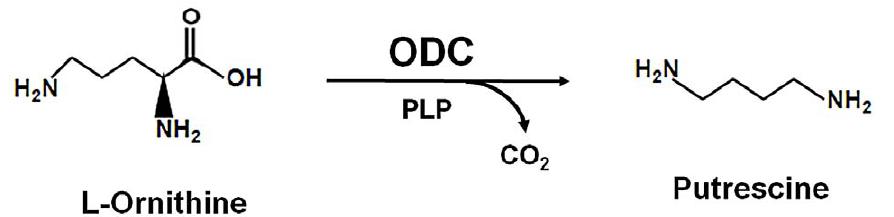
Figure 1. The enzymatic reaction catalyzed by ornithine decarboxylase. The pyridoxal phosphate (PLP)-dependent ODC enzyme catalyzes decarboxylation of ornithine and produces putrescine.